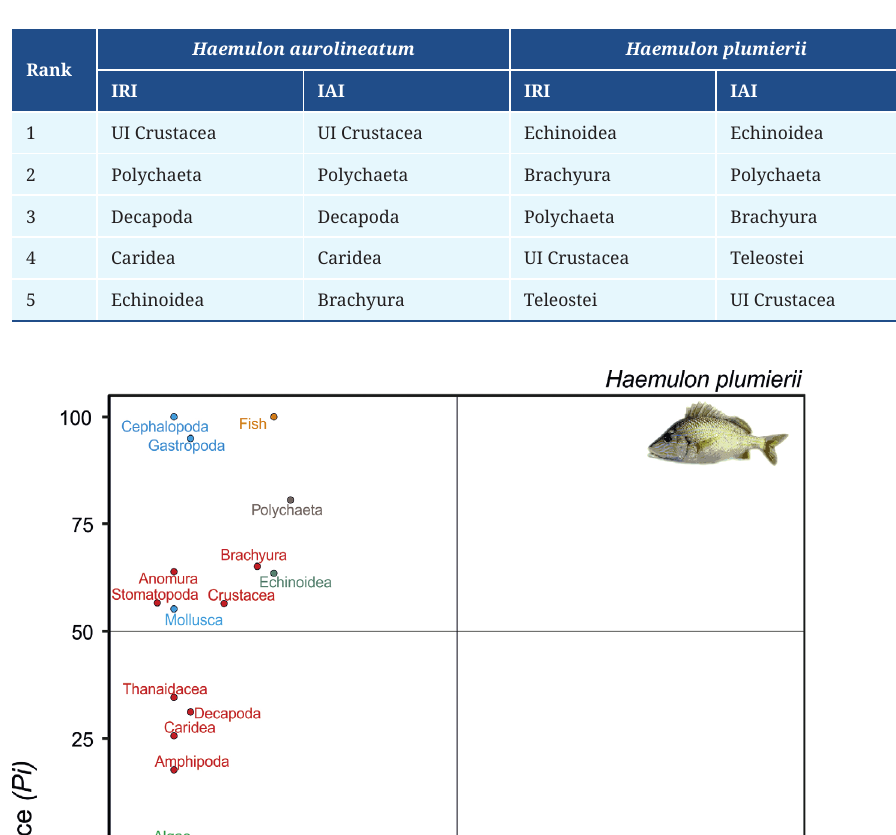
TABLE 2 | Ranking of importance of each category of prey item identified in the stomach content of Haemulon aurolineatum and H. plumierii according to each importance index (UI,